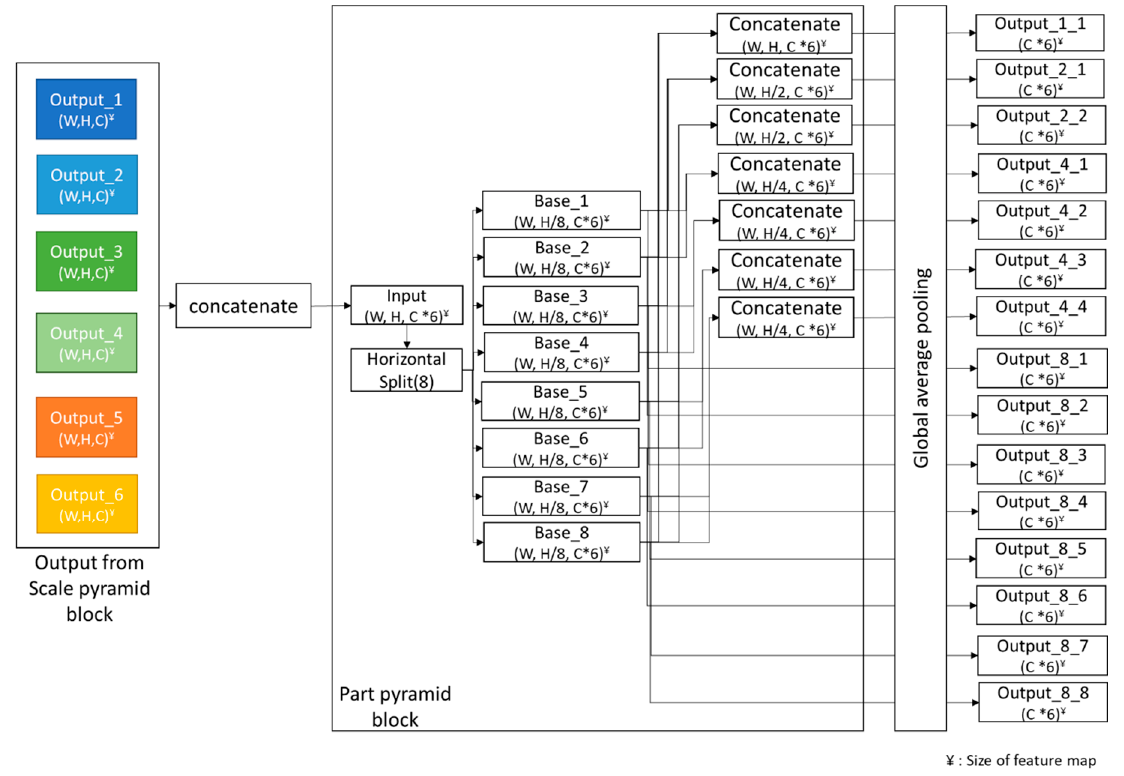
Figure 5. Network architecture of part pyramid.